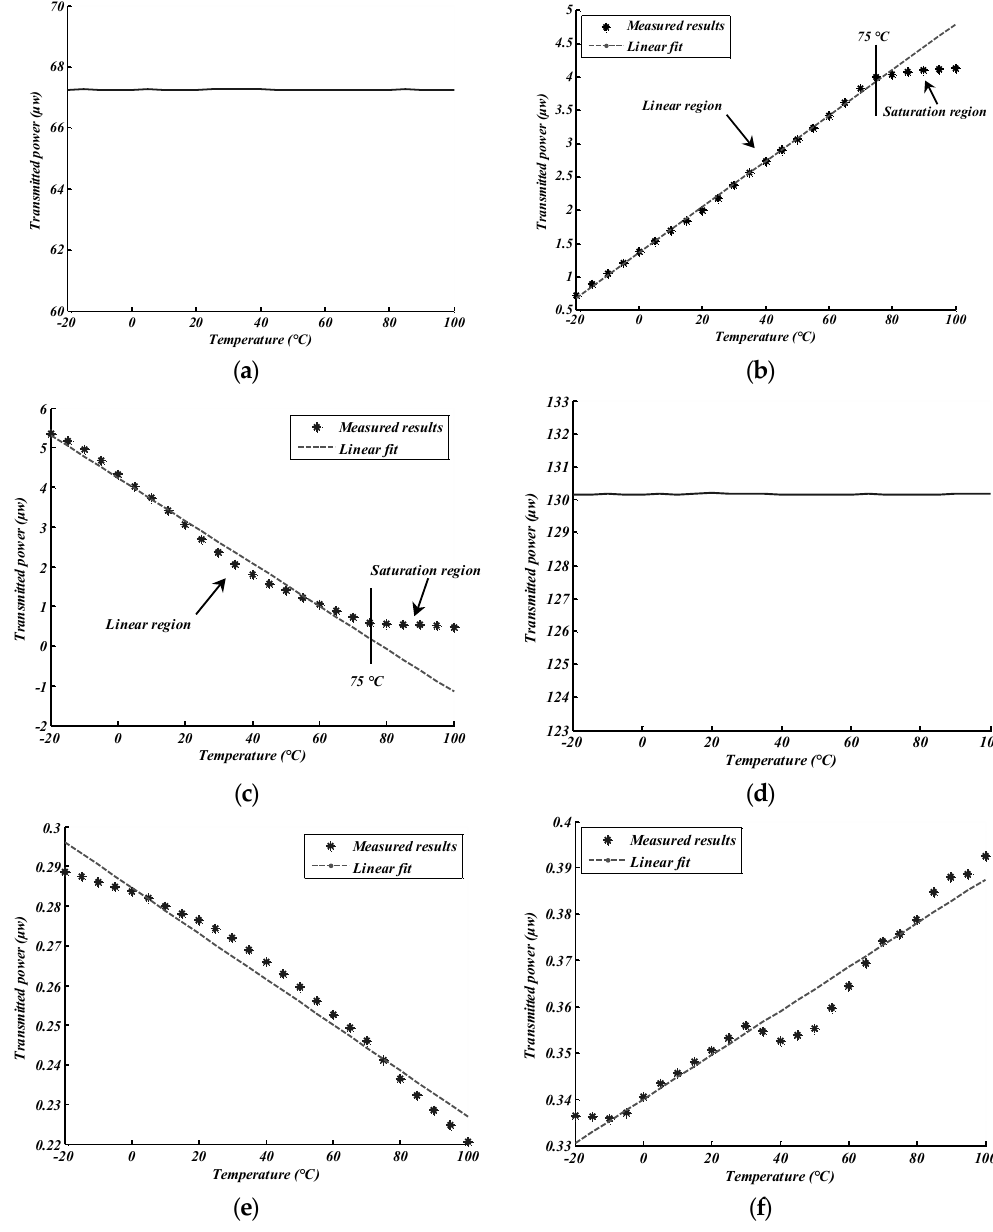
Figure 7. The relationship between light power and temperature ( a ) for transmitted light from cFBG A in Group I, ( b ) for reflected light from cFBG B in Group I, ( c ) for transmitted light from cFBG B in Group I, ( d ) for transmitted light from cFBG A in Group II, ( e ) for reflected light from cFBG B in Group II, and ( f ) for transmitted light from cFBG B in Group II. The dashed line in the figure is a linear fit using the least square method.